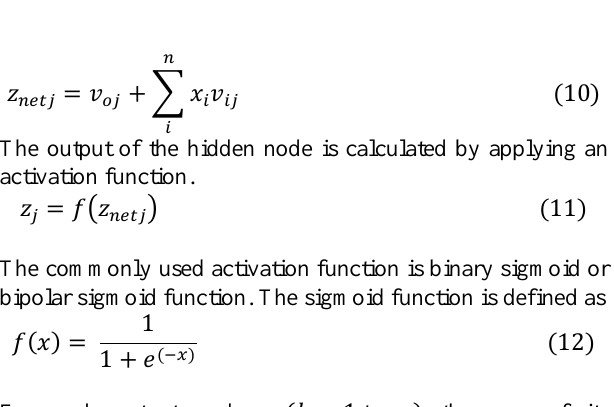
Figure 2 : Back-Propagation